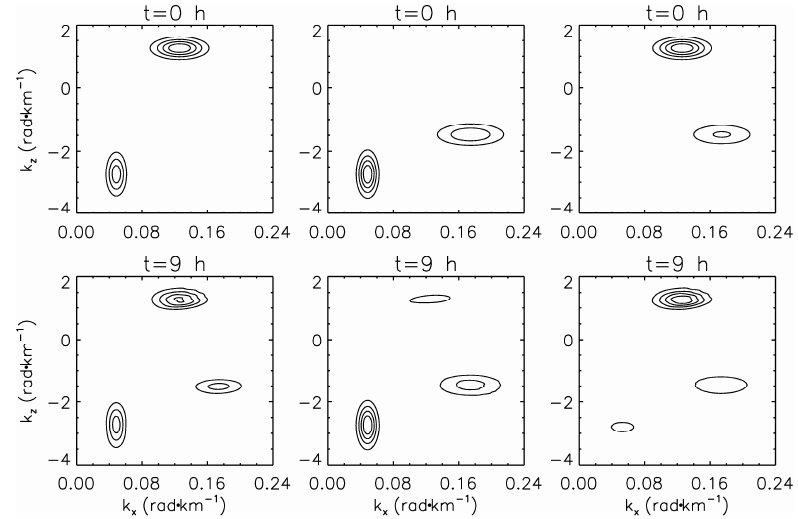
Fig. 2. Normalized wave number spectra of interacting wave triad in cases 1–3. The contour values are 0.2, 04, 0.6 and 0.8. The first, Figure 2. Normalized wave number spectra of interacting wave triad in cases 1-3. The contour values are secondary and third columns represent results in cases 1–3, 0.2, 04, 0.6 and 0.8. The first, secondary and third columns represent results in cases 1-3, respectively.